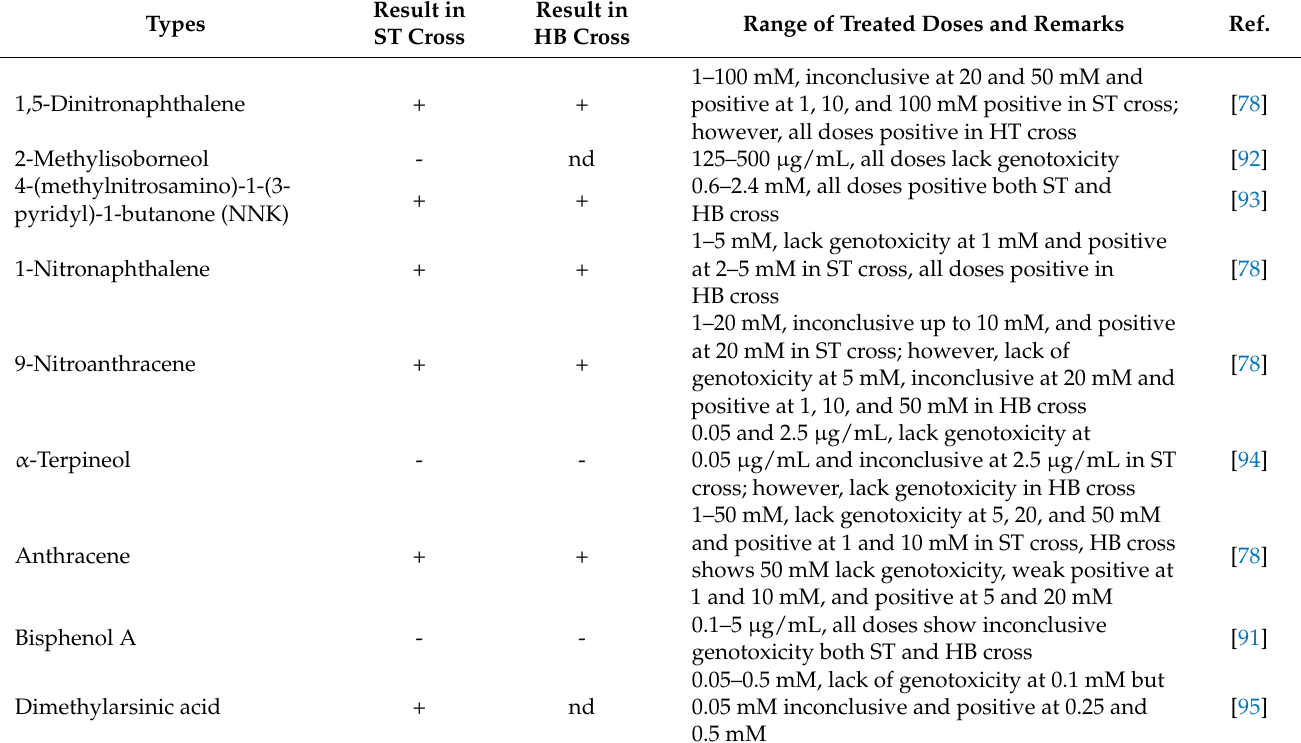
Table 4. Applications of SMART for testing chemicals in daily